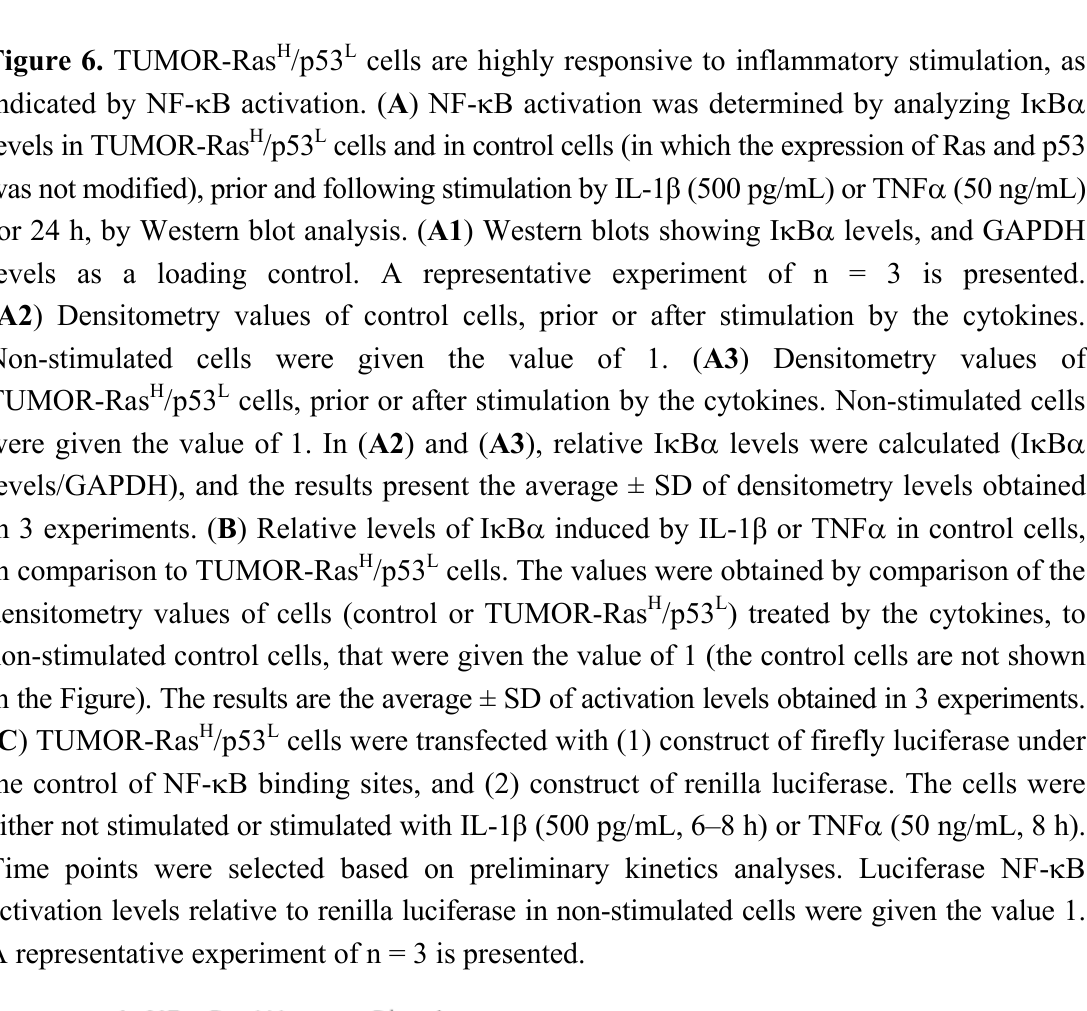
Figure 6. TUMOR-Ras H /p53 L cells are highly responsive to inflammatory stimulation, as indicated by NF-  B activation. ( A ) NF-  B activation was determined by analyzing I  B